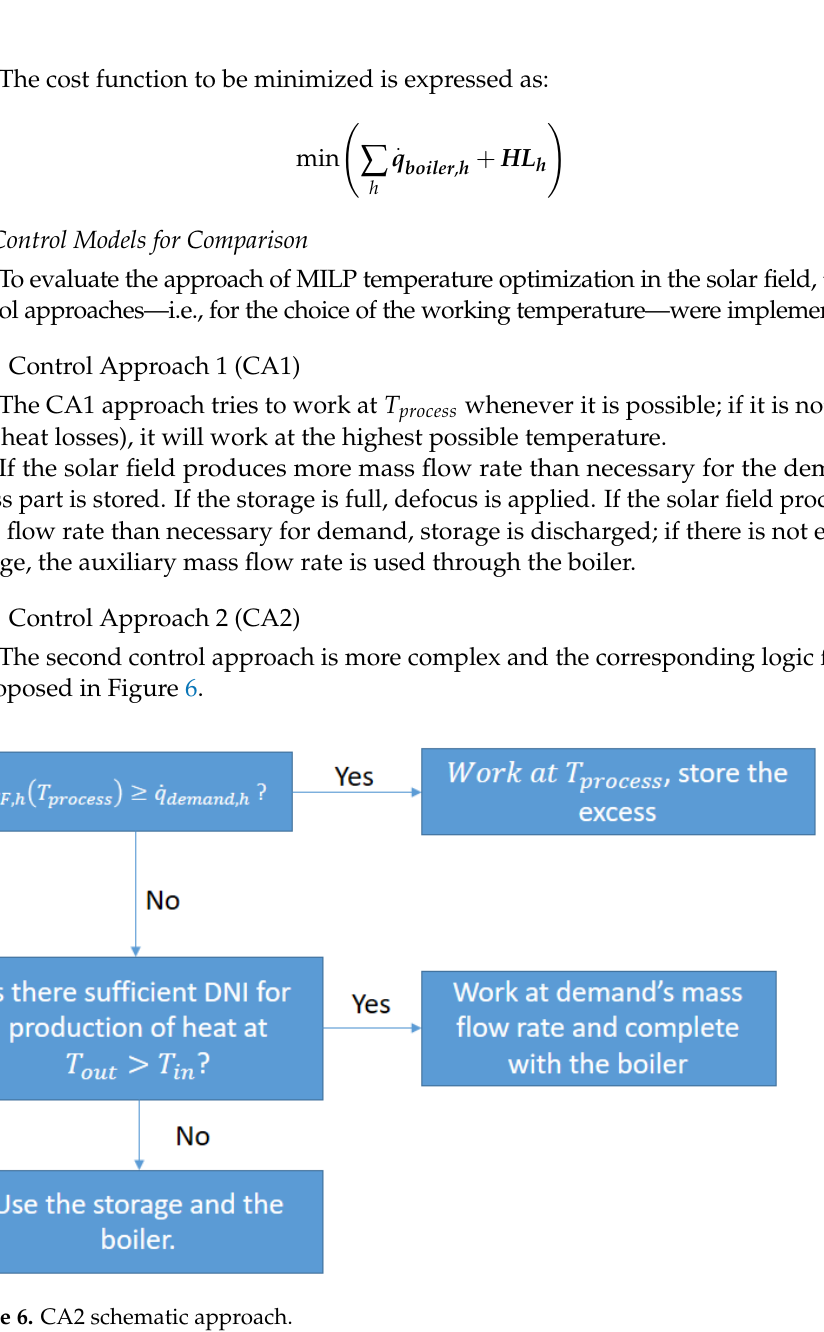
Table 1. Summary of the case study’s parameters.